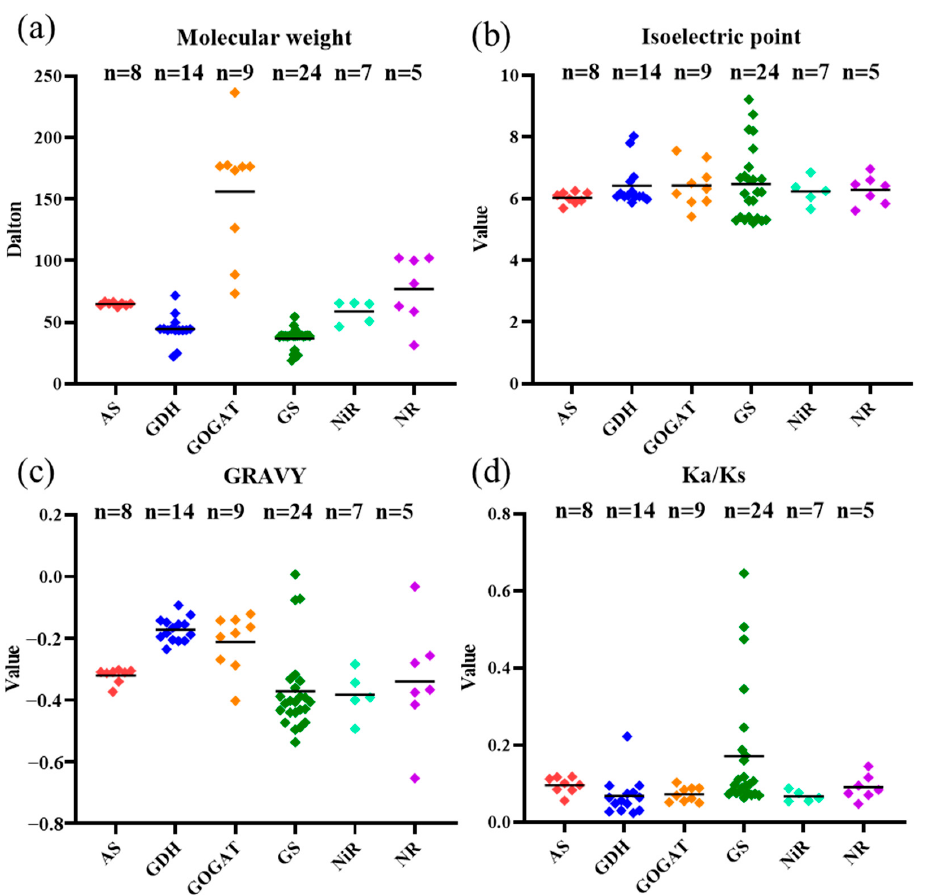
Figure 1. Molecular characterization of the NAGs in Brassica napus . ( a ) Molecular weight; ( b ) theoretical isoelectric point; ( c ) grand average of hydropathy; ( d ) nonsynonymous (Ka)/synonymous (Ks) values. Genes from the same group are shown by the same color. AS, asparagine synthetase; GDH, glutamate dehydrogenase; GOGAT, glutamine oxoglutarate aminotransferase; GS, glutamine synthetase; NiR, nitrite reductase; NR, nitrate reductase.